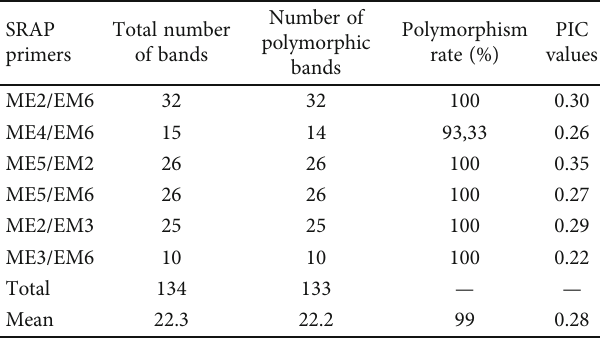
Table 4: Analysis of SRAP primer combinations